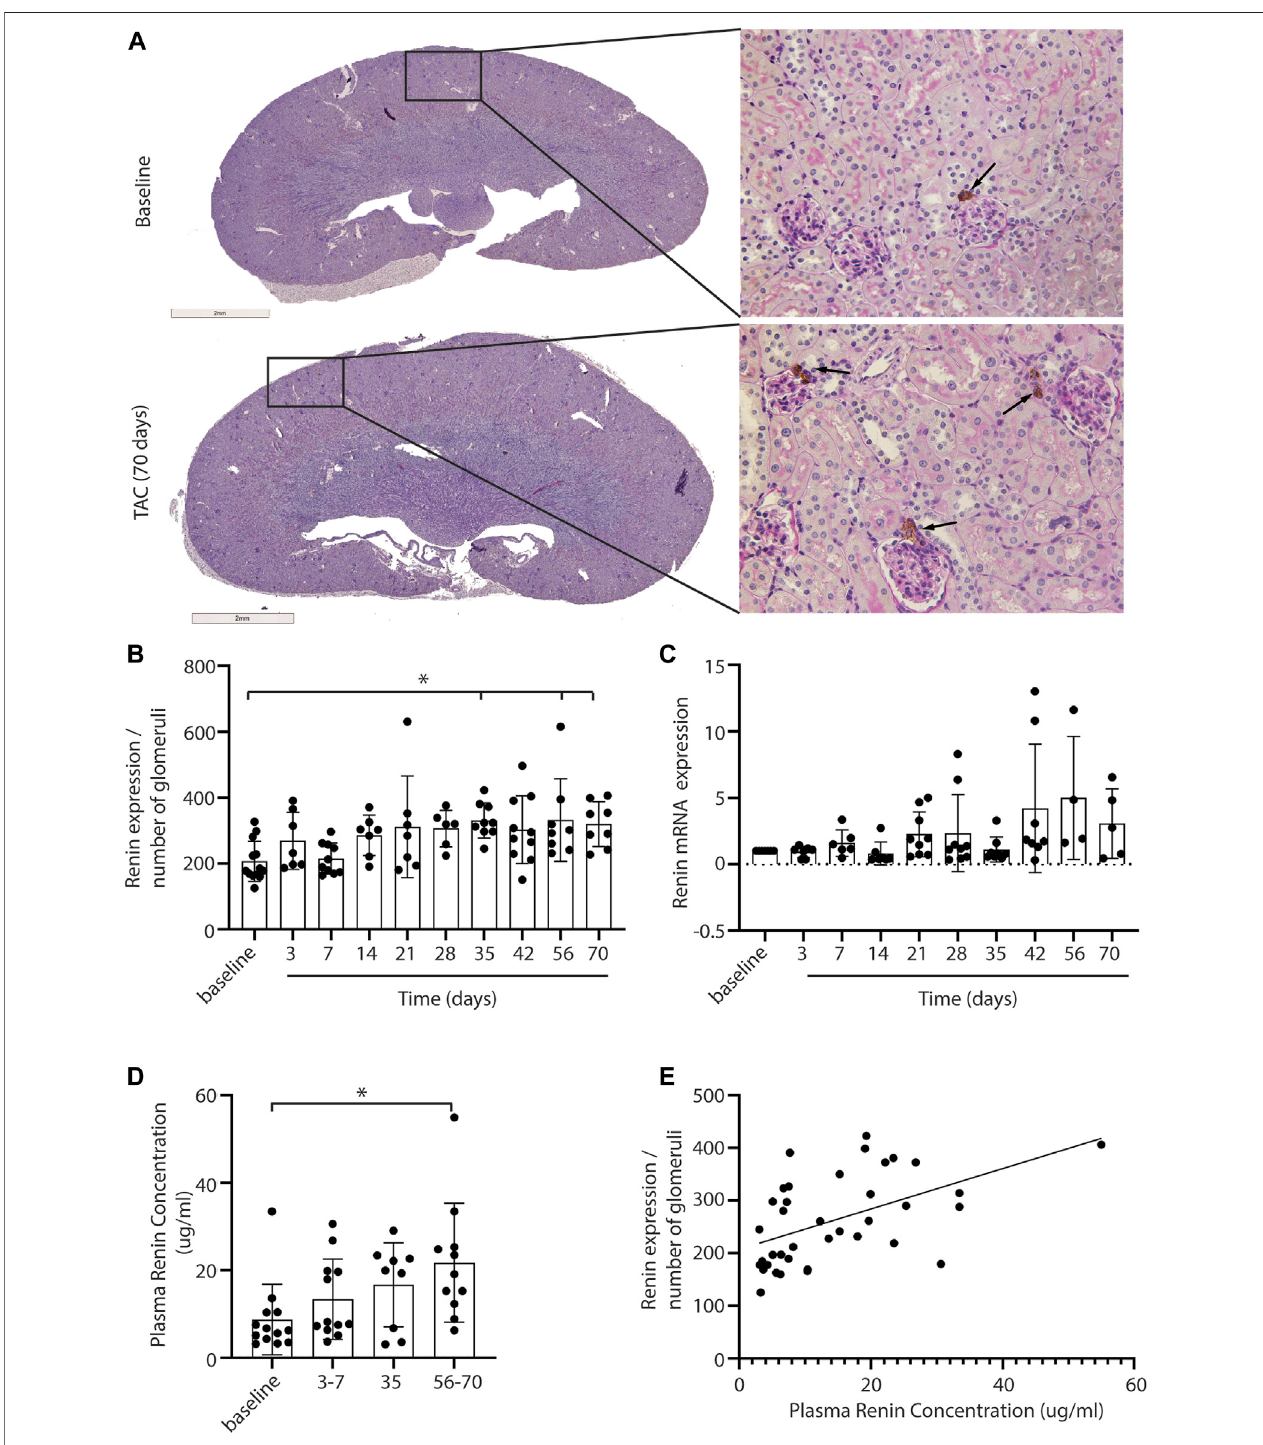
FIGURE2| RenalreninexpressionafterTAC.Representativepicturesofreninexpressionatbaselineandafter3 – 70 daysofTAC (A) .Reninexpression(depictedin brown) is visible in the juxtaglomerular cells close to the glomeruli (arrows). Renin expression, corrected for the number of glomeruli present in the section, is increased from day 35 compared to baseline (B) . qPCR analysis of renin expression showed a trend of increased renin over time (C) , 20 mice were excluded from the renin qPCR analysisasthelevelswerebelowthedetection limit.Inlinewithrenalrenin,theplasmareninconcentrationisincreasedsigni fi cantlyat56 – 70 days post-TAC (D) . A signi fi cant association between local and systemic renin is observed (r (cid:1) 0.52, R2 (cid:1) 0.27, p (cid:1) < 0.001) (E) . Mean ± SD, * (cid:1) p < 0.05.